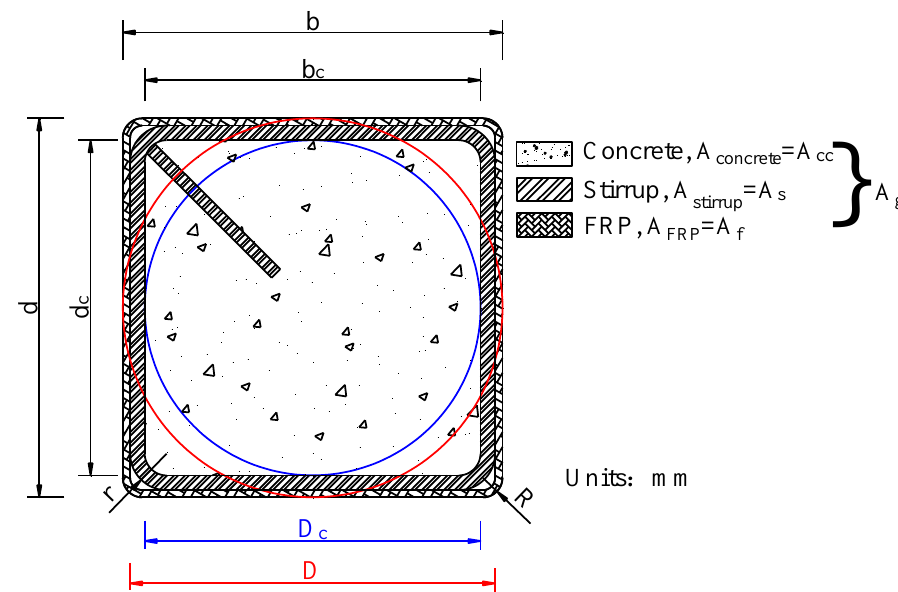
Figure 1. Details of FRP – steel − confined rectangular concrete columns (units: mm).